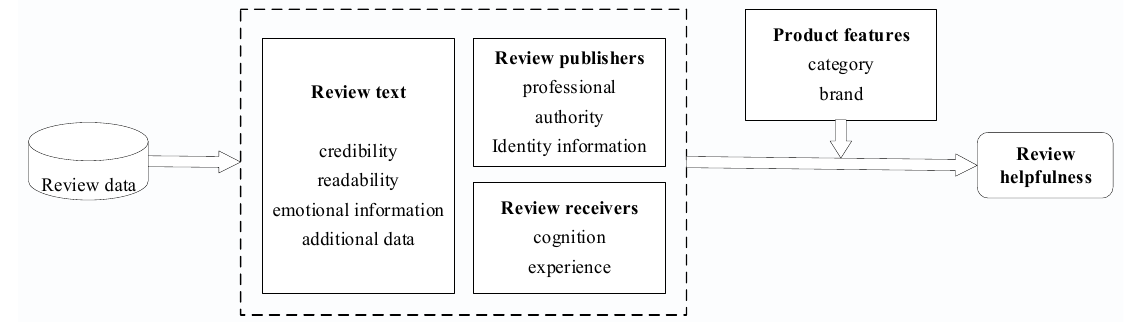
Figure 4. Research framework of online review helpfulness.